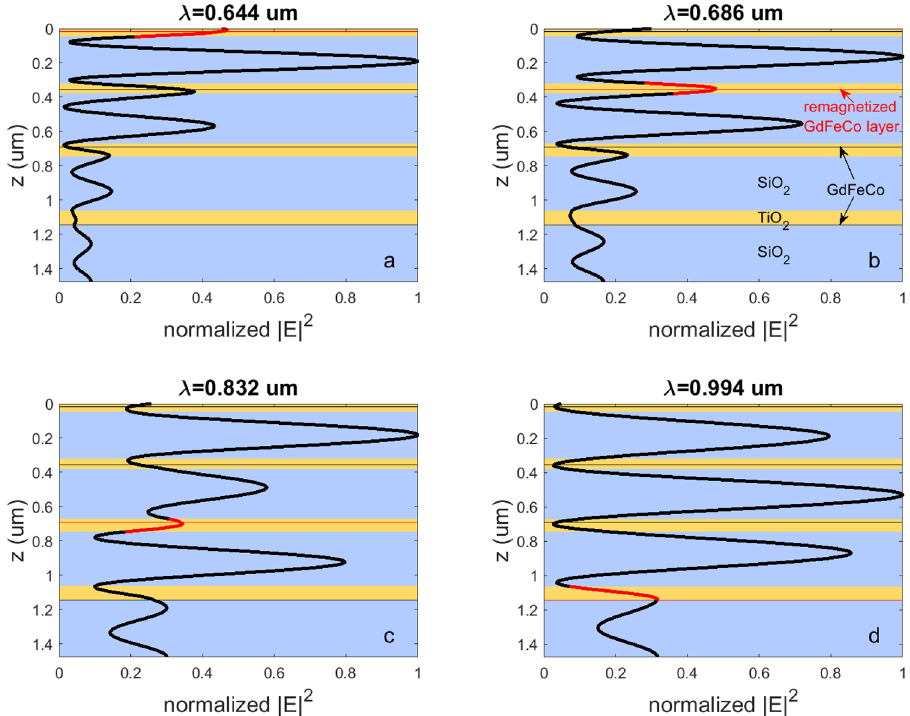
Figure 3. The spatial distribution of the normalized |E| 2 in the chirped MPC with the smooth GdFeCo layer at the ‘operating’ wavelengths of ( a ) 644 nm, ( b ) 686 nm, ( c ) 832 nm, ( d ) 994 nm. Red sections of the curve show the magnitude of the normalized |E| 2 inside the addressed GdFeCo layer and nearby. The yellow areas correspond to TiO 2 layers, the blue regions refer to SiO 2 layers, and the red and black lines indicate the position of the 3 nm-thick GdFeCo layers. The red ones denote the position of the remagnetized layers, and the black ones refer to the GdFeCo layers with untouched